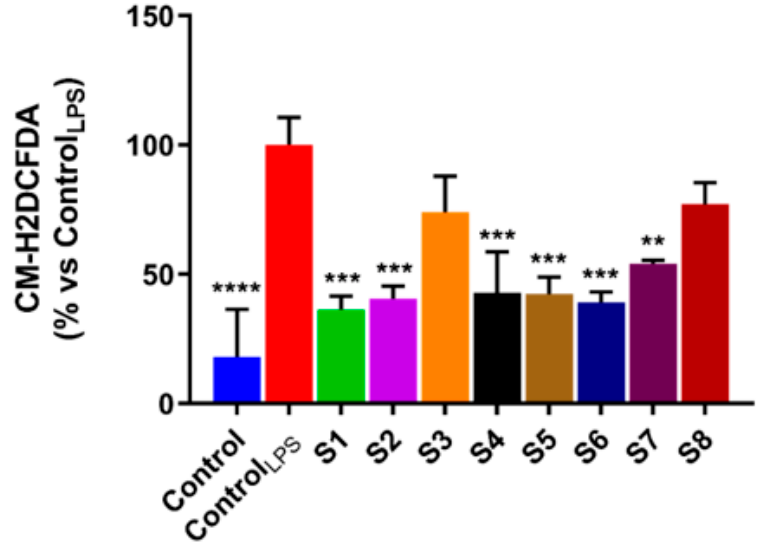
Figure 3. Salvia officinalis extracts decrease the reactive oxygen species (ROS) in lipopolysaccharide (LPS)-stimulated RAW 264.7 cells. Cells were exposed to S. officinalis extracts (S1-S8), for 24 h; ROS intracellular levels were assessed, using the CM-H2DCFDA dye, as reported in Materials and Methods. Values are the mean ± SD of three independent experiments, each one performed in triplicate. P- values were calculated vs. control LPS ; ** p < 0.01; *** p < 0.001; **** p < 0.0001.